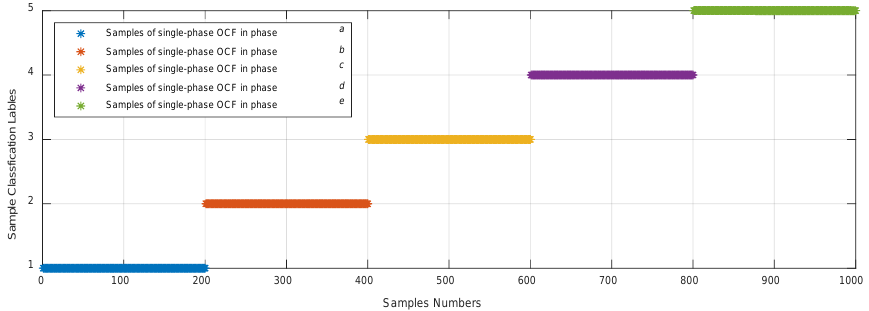
Figure 17. The 1000 samples with their corresponding labels.